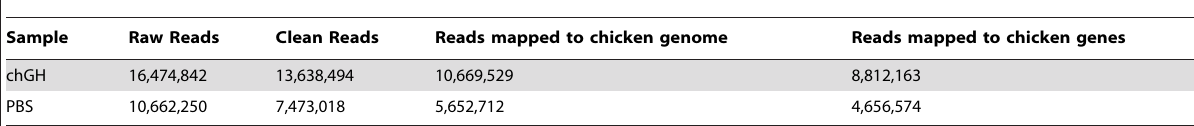
Table 1. An overview of mRNA sequencing results.